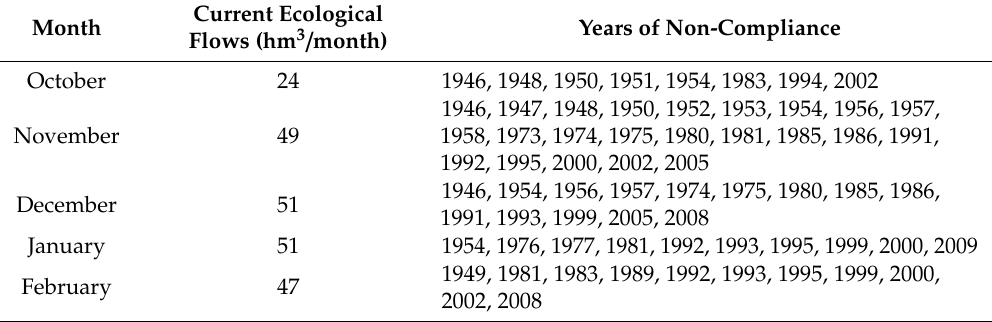
Table 6. Gauging station “Pulo do Lobo” (27L / 01H SNIRH; main course of the Lower Guadiana River): months with streamflows lower than the current requirements of ecological flows by the Spanish and Portuguese Hydrological Plans of the Guadiana Hydrographic Demarcation [21,22]. Data